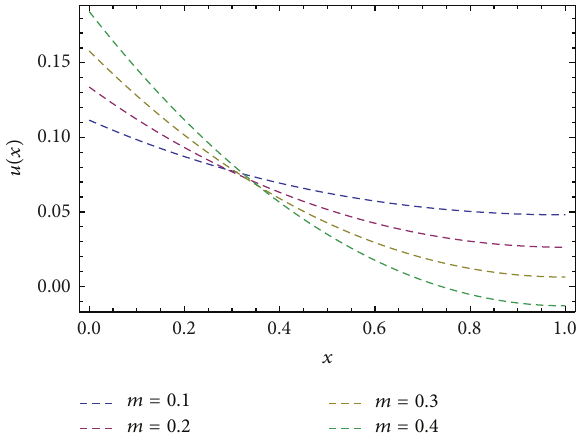
Figure 7: The figure shows this gravity effect of “ 𝑚 ” on velocity profile for lift problem, where 𝛼 = 0.1 , 𝛽 = 1 , 𝑀 = 1 , and Λ = 0.2